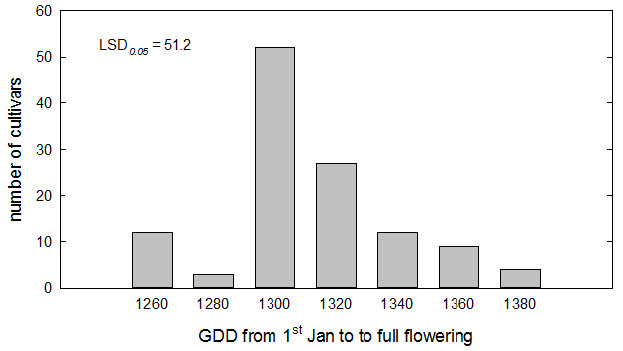
Figure 4. Distribution of cultivars according to the heat requirement to flower, expressed as growing degree days (Tbase = 2.25 °C) cumulated after January 1 up until full flowering.